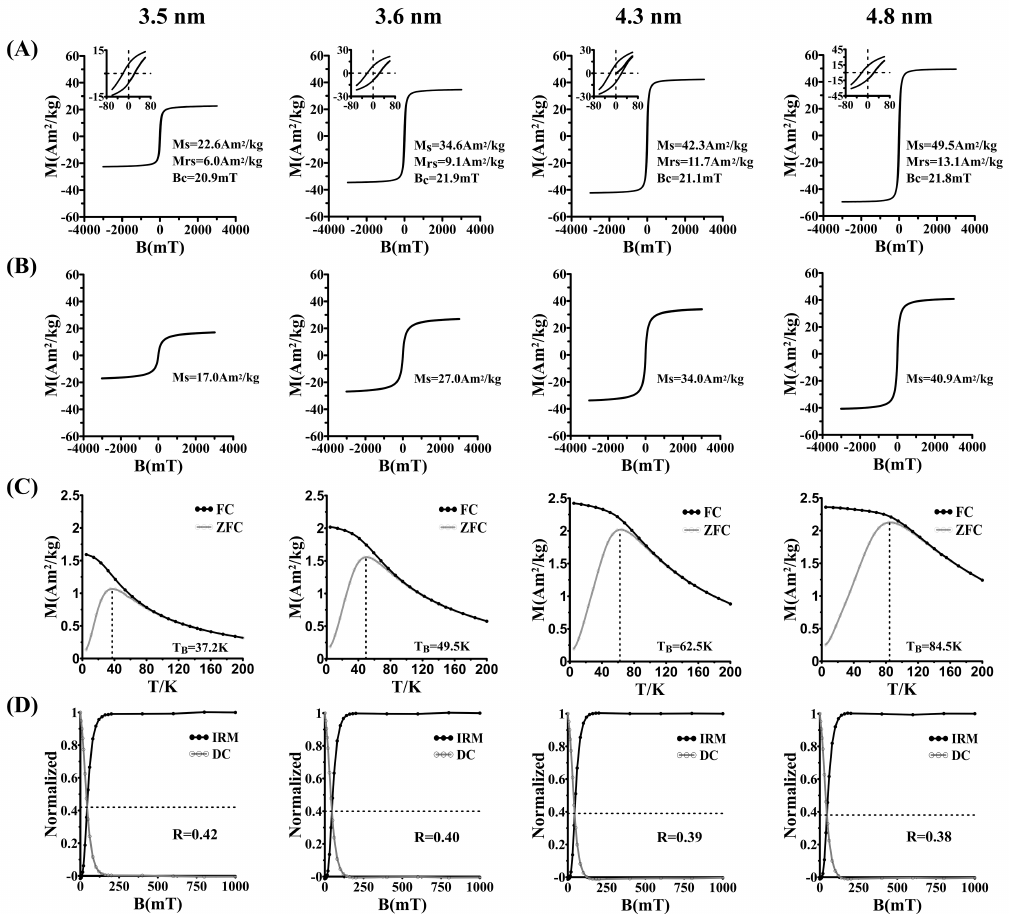
Figure 2. Magnetism characterization for synthesized MHFn nanoparticles. Row ( A ). hysteresis loops measured at 5 K. Subgraph is an enlargement of the field at ± 80 mT. Row ( B ). hysteresis loops measured at 300 K. Row ( C ). ZFC / FC magnetization curves. Row ( D ). normalized IRM acquisition and DC demagnetization of SIRM measured at 5 K.